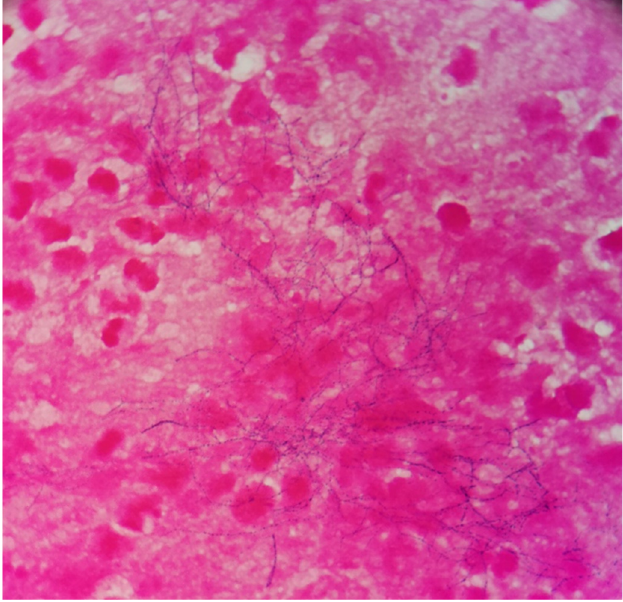
Figure 2. The gram stain revealed gram-positive filamentous and beaded bacteria (×1000).